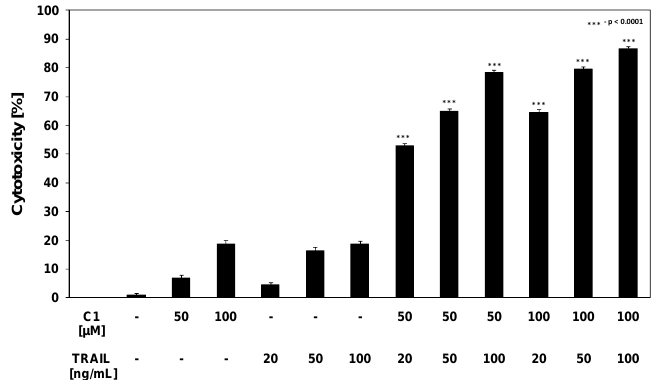
Figure 4. Cytotoxic activity of TRAIL in combination with chalcones and dihydrochalcones in LNCaP prostate cancer cells. The cancer cells were incubated for 48 hours with TRAIL at the concentrations of 20–100 ng/mL and the compounds C1–C5 at the concentrations of 50–100 μ M. The percentage of cell death was measured by MTT cytotoxicity assay. The values represent mean ±SD of three independent experiments performed in quadruplicate (n = 12). *** = significantly different from control or TRAIL (p <